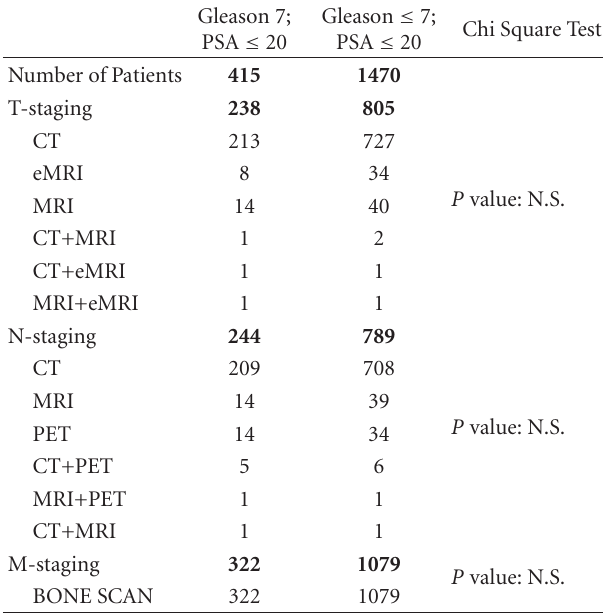
Table 4: Di ff erence in the use by Italian urologists of imaging procedures for TNM staging between EAU and AUA guidelines ( P value calculated by chi-square